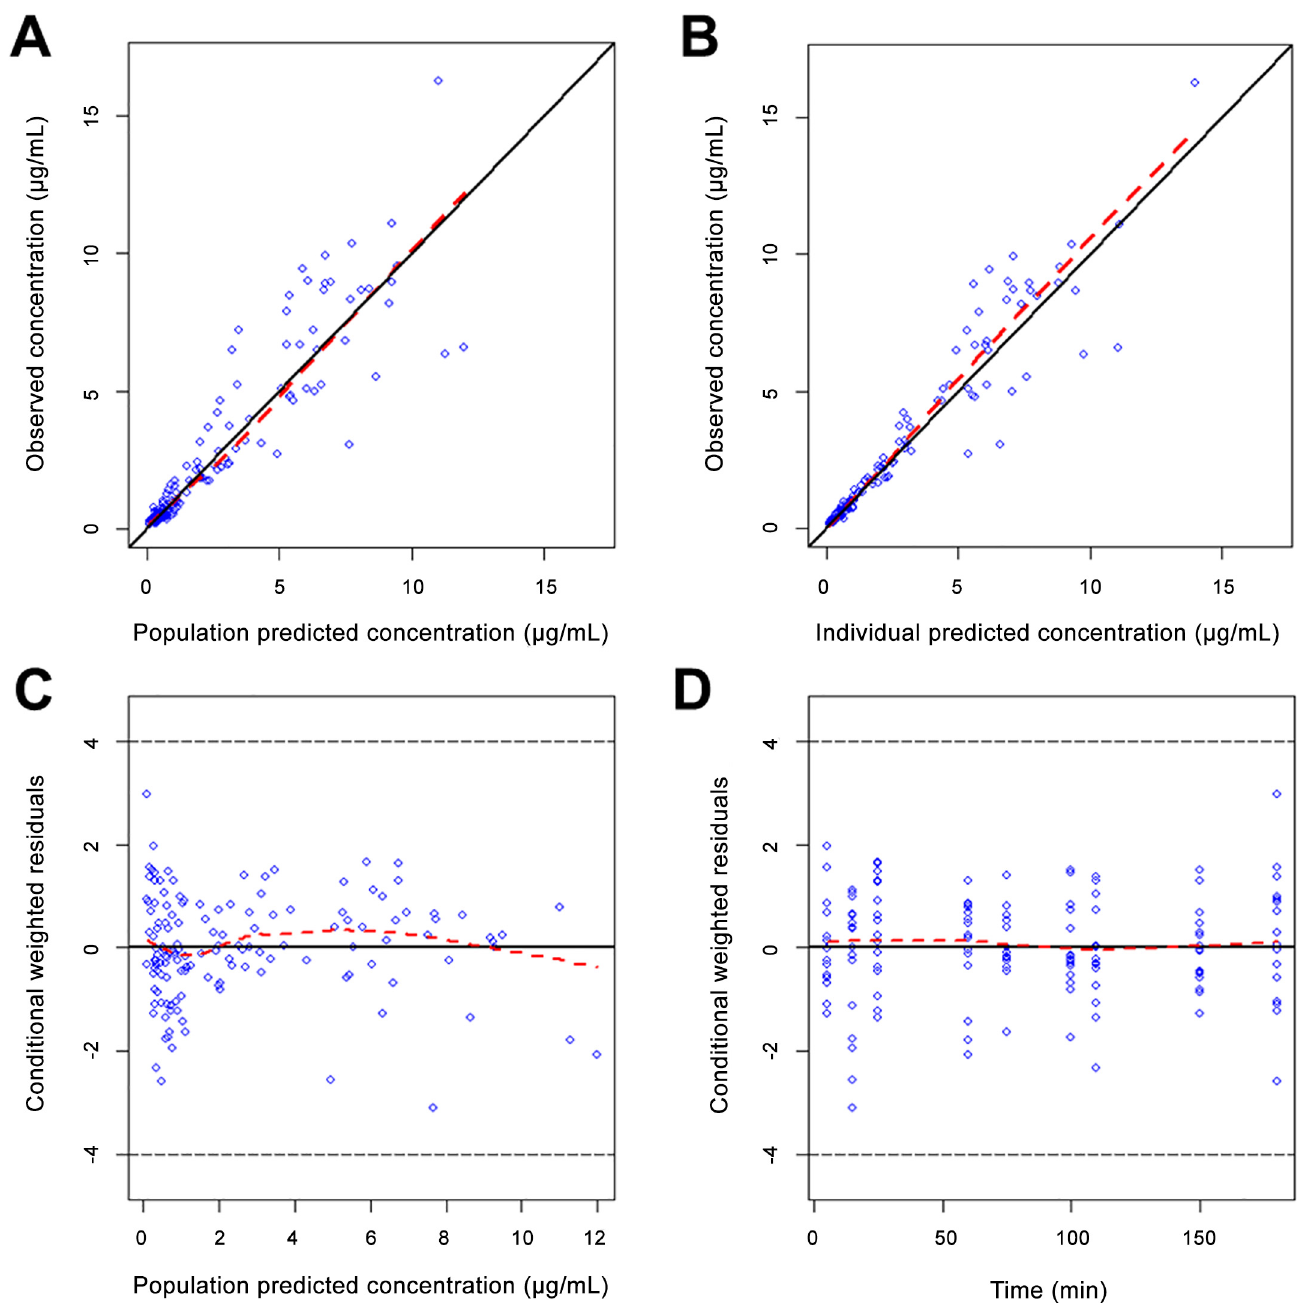
Fig 5. Goodness-of-fit plots for the final PK model. (A) Population prediction versus observed concentration. (B) Individual prediction versus observed concentration. (C) Conditional weighted residuals (CWRES) versus population prediction. (D) Conditional weighted residuals (CWRES) versus time. Dashed red line, a locally weighted least-squares regression; solid black line, line of